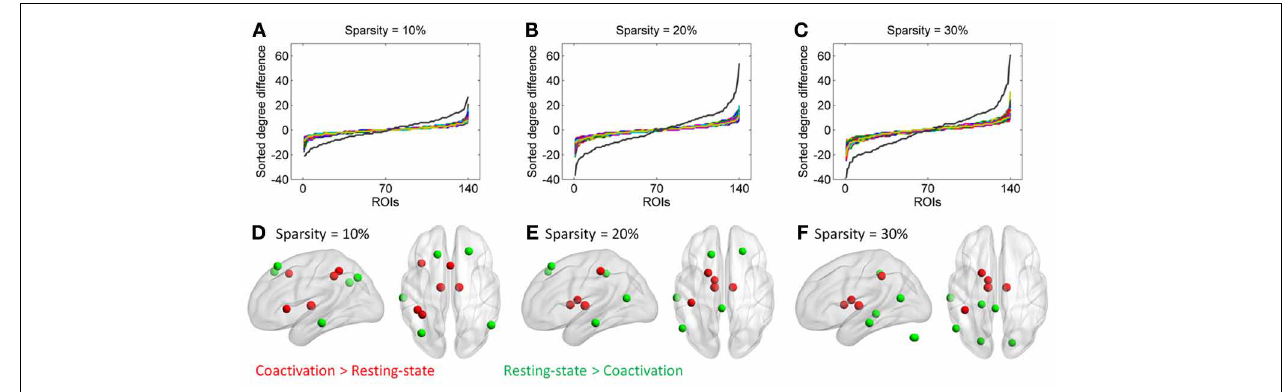
FIGURE 5 | Top row, sorted degree differences of 140 ROIs between the coactivation network and the resting-state network at sparsity of 10% (A), 20% (B), and 30%(C), respectively. The chromatic lines represent sorted degree differences of scrambled networks for 1000